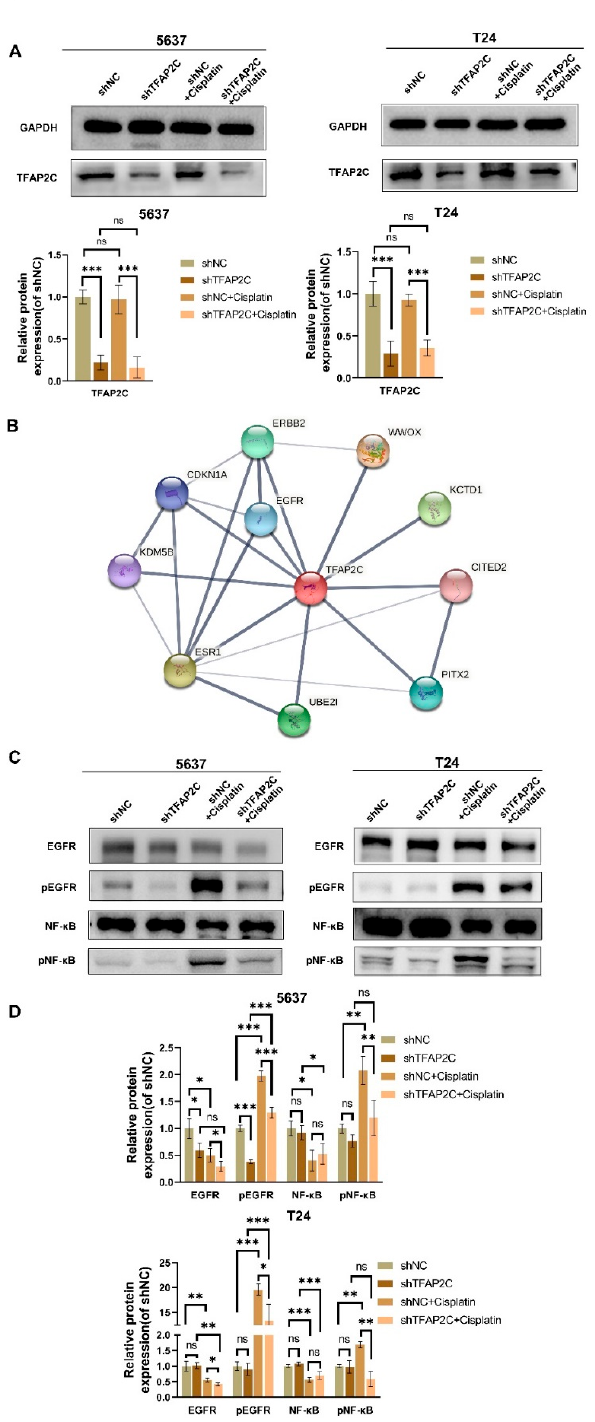
Figure 6. Activation of EGFR and NF- κ B induced by cisplatin is affected by TFAP2C. ( A ) The protein expression level of TFAP2C in T24 and 5637 cells. The TFAP2C protein expression level was not increased by cisplatin. ( B ) The results from the STRING database revealed the protein interaction partners for TFAP2C. ( C , D ) Protein expression levels of EGFR, pEGFR, NF- κ B, and pNF- κ B. Data represent the mean (± standard deviation, SD) of three independent experiments (* p < 0.05, ** p < 0.01, *** p < 0.001, ns, not significant).